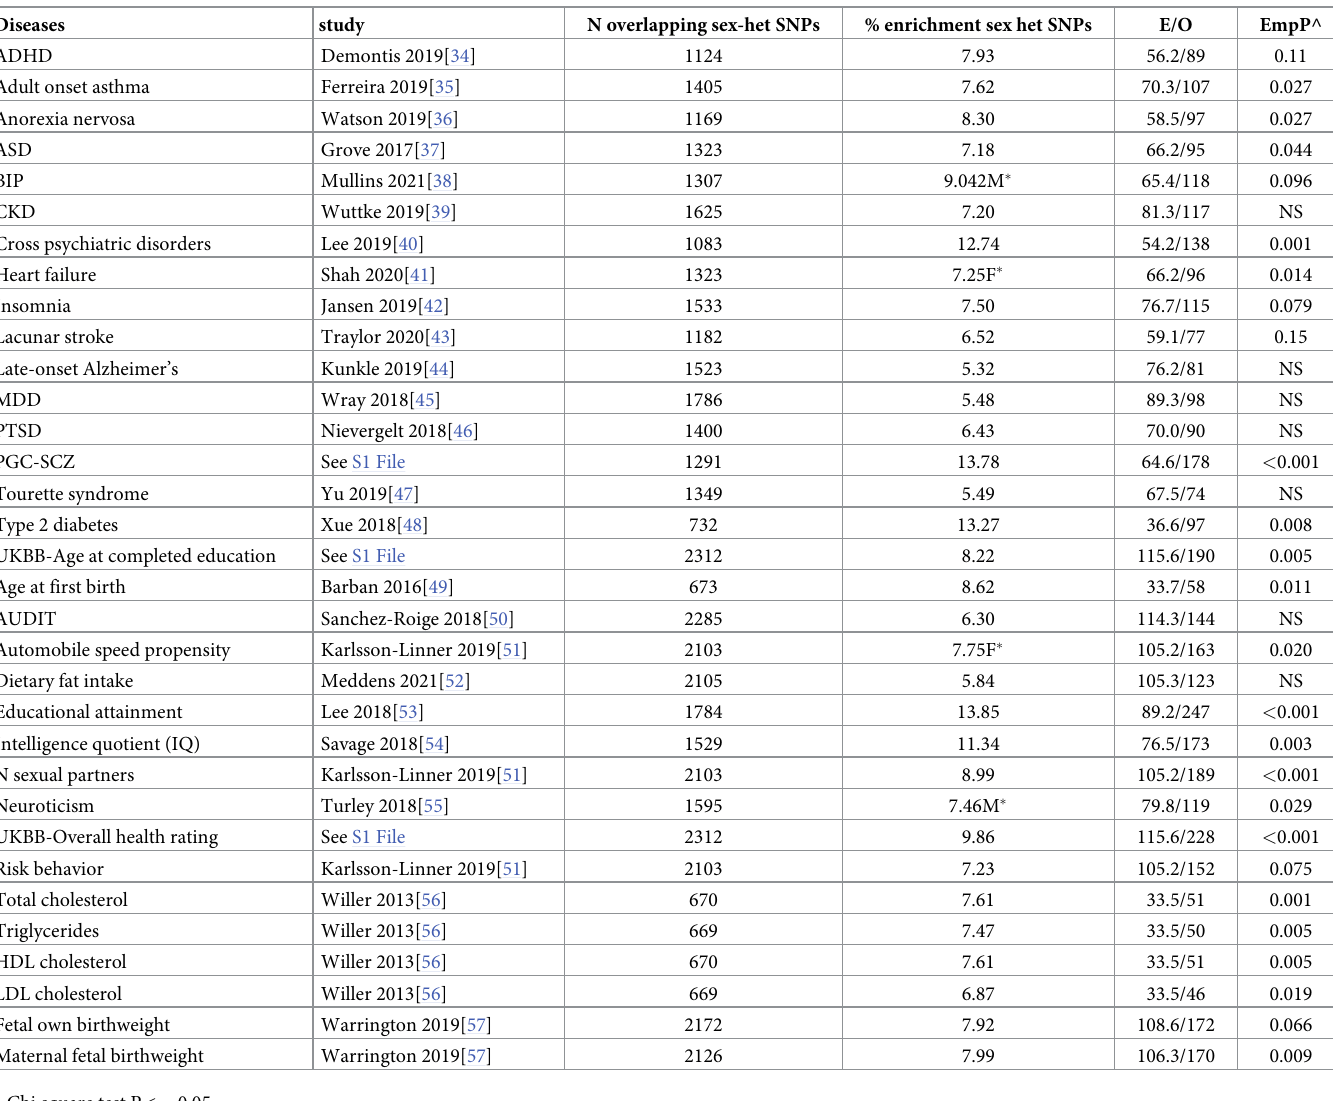
Table 2. Enrichment of biometric trait sex-heterogeneous SNPs in summary statistics for N = 16 diseases and N = 17 human phenotypes.